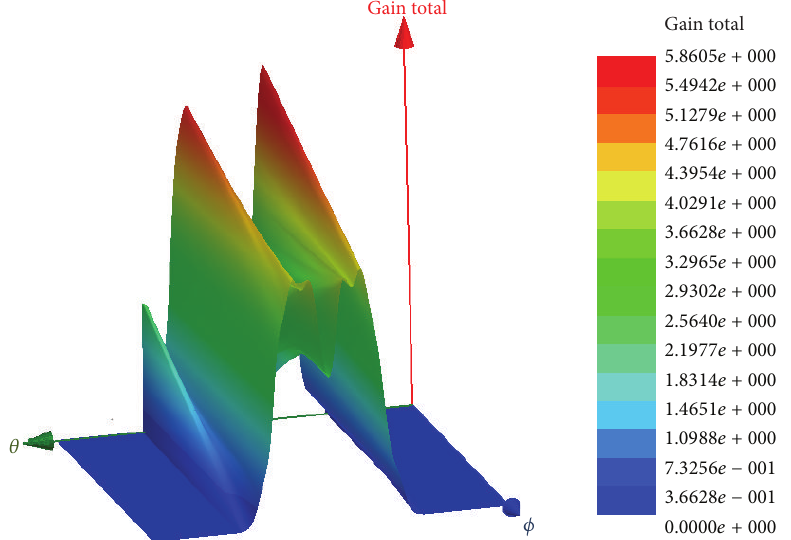
Figure 18: 3D gain of the CRA for the third iteration at 8.5 GHz.